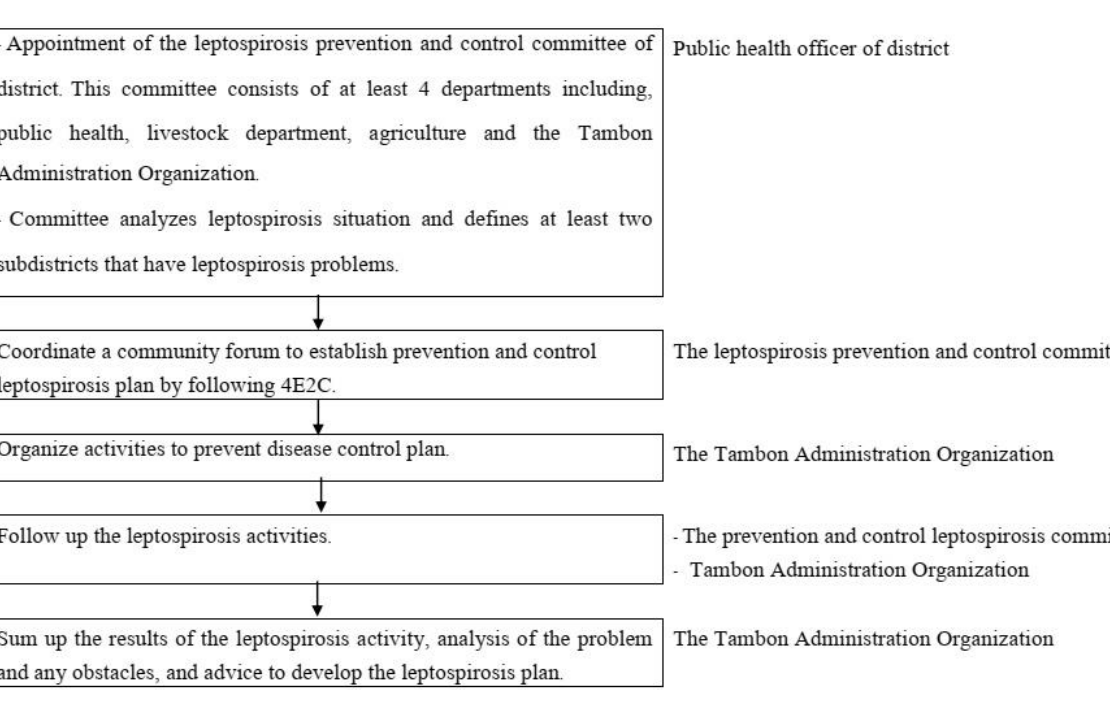
Figure 2. Procedures for establishing leptospirosis network.